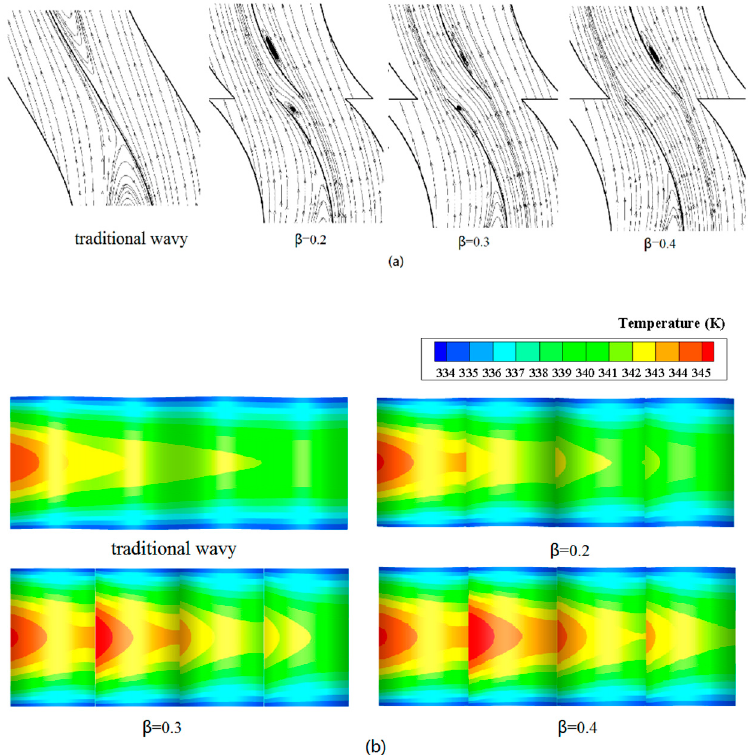
Figure 8. ( a ) Change in the streamline and ( b ) fin surface temperature distribution of the traditional wavy fin and staggered wavy fin when the staggered ratios are 0.2, 0.3 and 0.4.